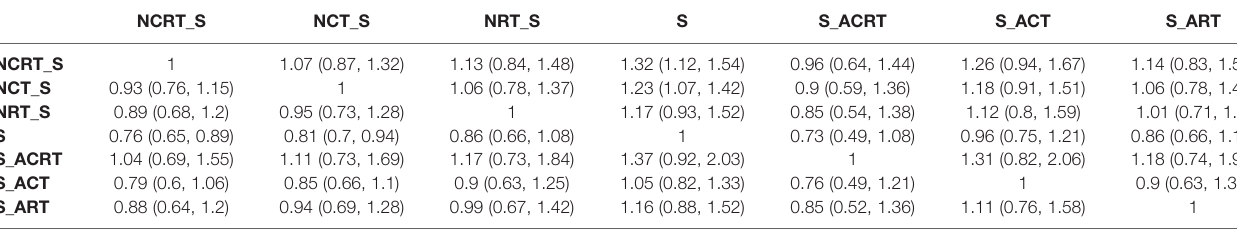
TABLE 2 | The treatment effect for all the evaluated treatment